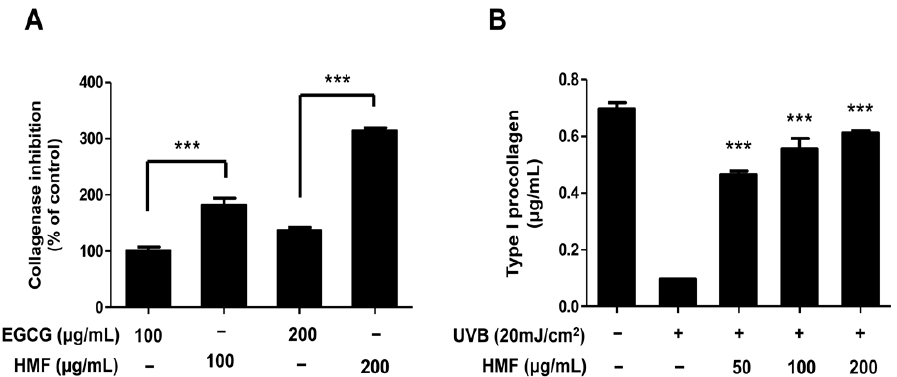
Figure 2. Effects of 3,5,6,7,8,3 ′ ,4 ′ -heptamethoxyflavone (HMF) on cellular collagenase activity and type I procollagen content of HDFn cells. ( A ) Cellular collagenase inhibitory activity and ( B ) type I